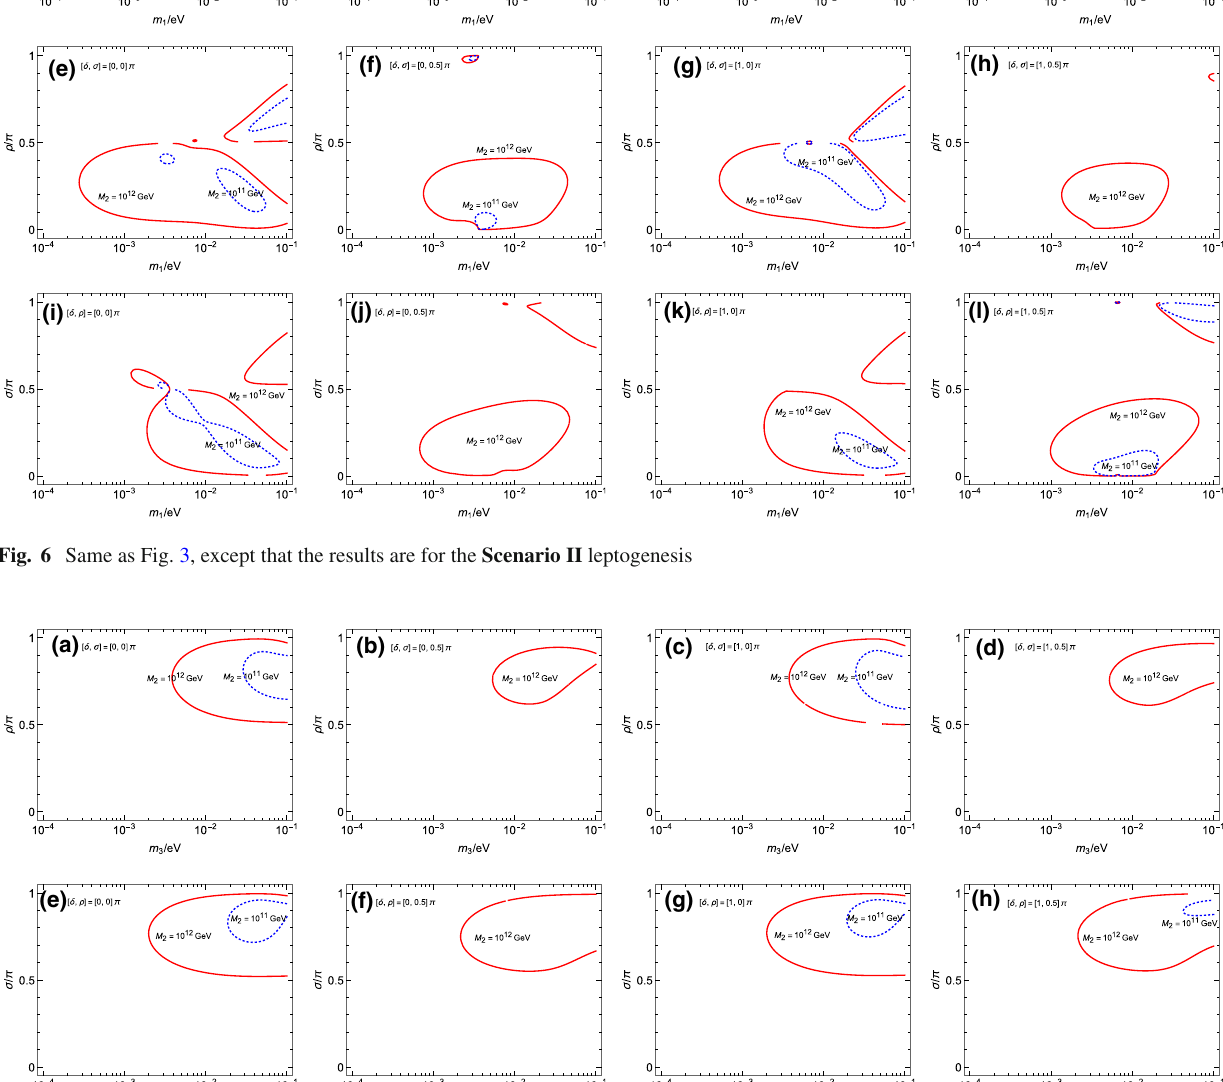
ues of ρ versus m 3 for the Scenario II leptogenesis to be successful. Second row: same as the first row, except that the roles of ρ and σ are